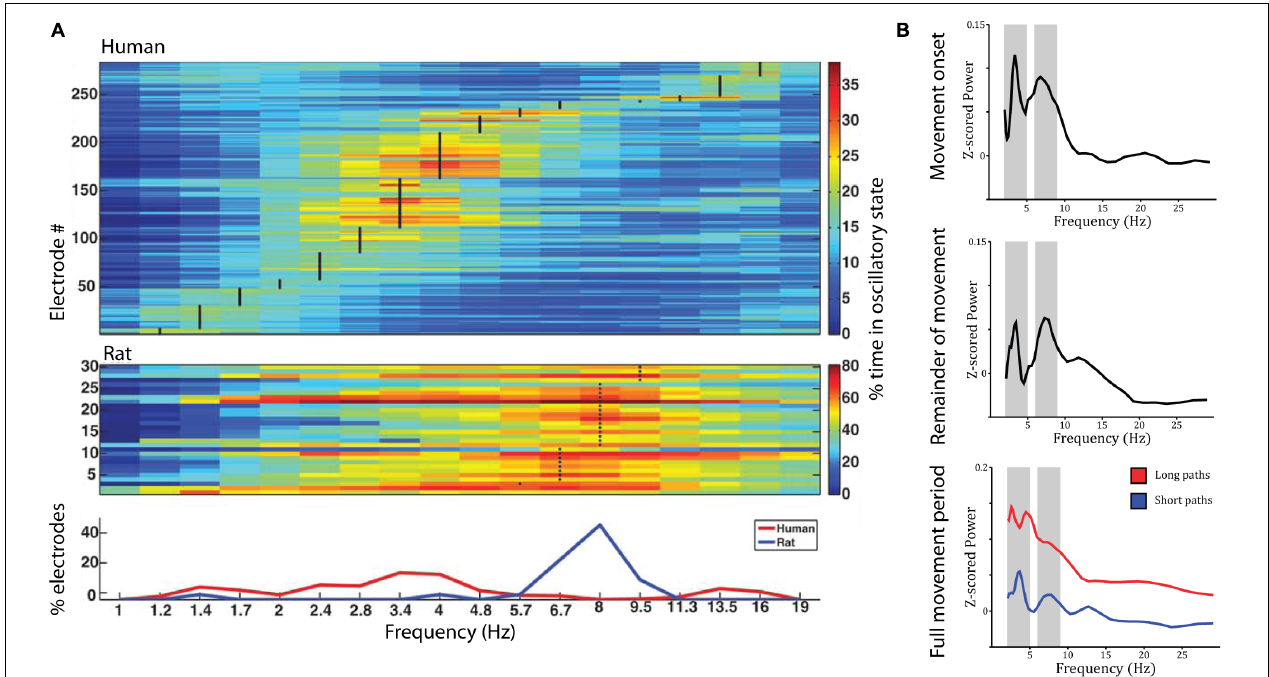
FIGURE 3 | Theta oscillations during virtual navigation. (A) The predominant frequency of oscillations occurring during virtual navigation appears to be lower in humans than rats. A clear peak around 8 Hz is evident in rats, while human data shows a peak around 3–4 Hz. Adapted with permission (Watrous et al., 2013a) from Wiley Periodicals. (B) Theta oscillations are evident in the power spectrum during movement onset ( top ), the remainder of the movement period ( middle ), and the full movement period ( bottom ) in two distinct frequency bands around 3–4 and 8–9 Hz, at the edges of the conventional theta rhythm. Theta oscillations are of higher amplitude during long compared to short paths ( bottom